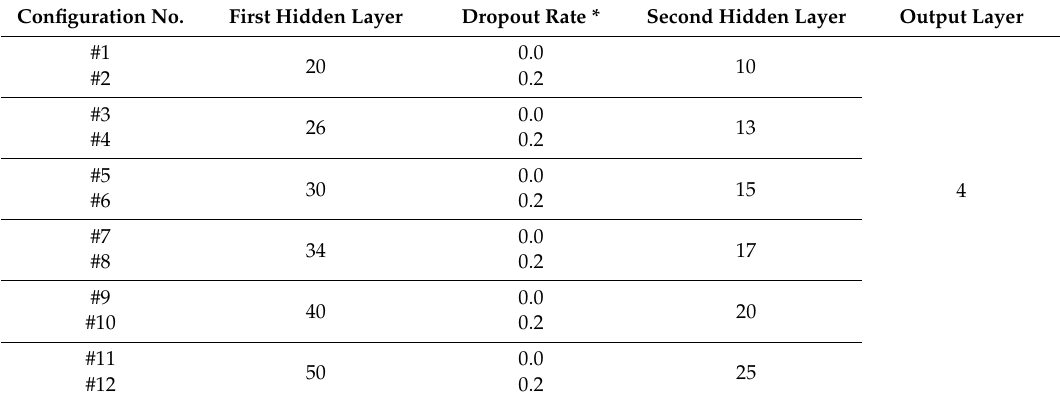
Table 2. Number of neurons in the tested two-layer perceptron